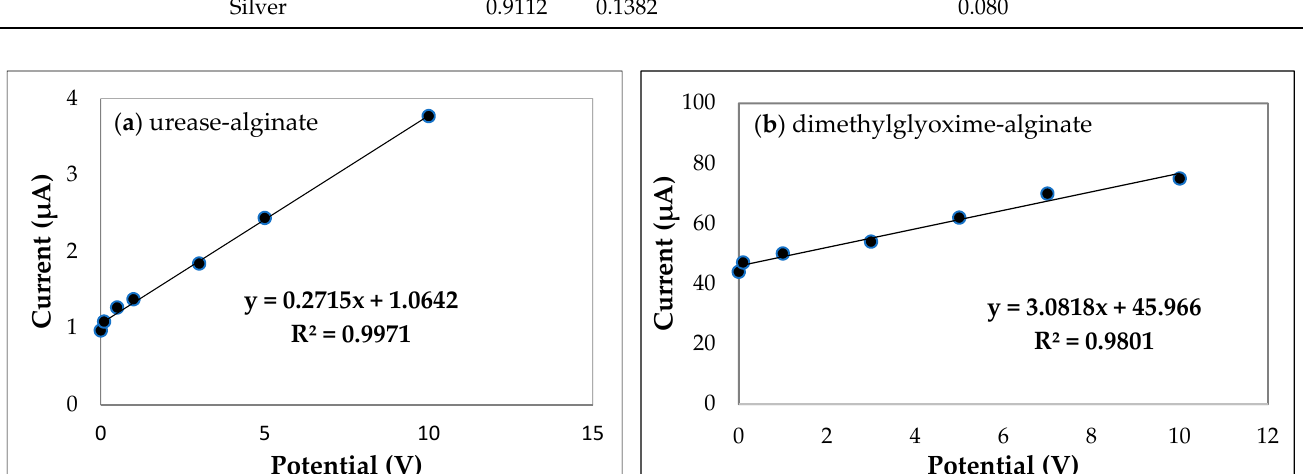
Figure 3. Calibration curve for cyclic voltammograms ( a ) biosensor with urease-alginate and ( b ) dimethylglyoxime-algi- nate.